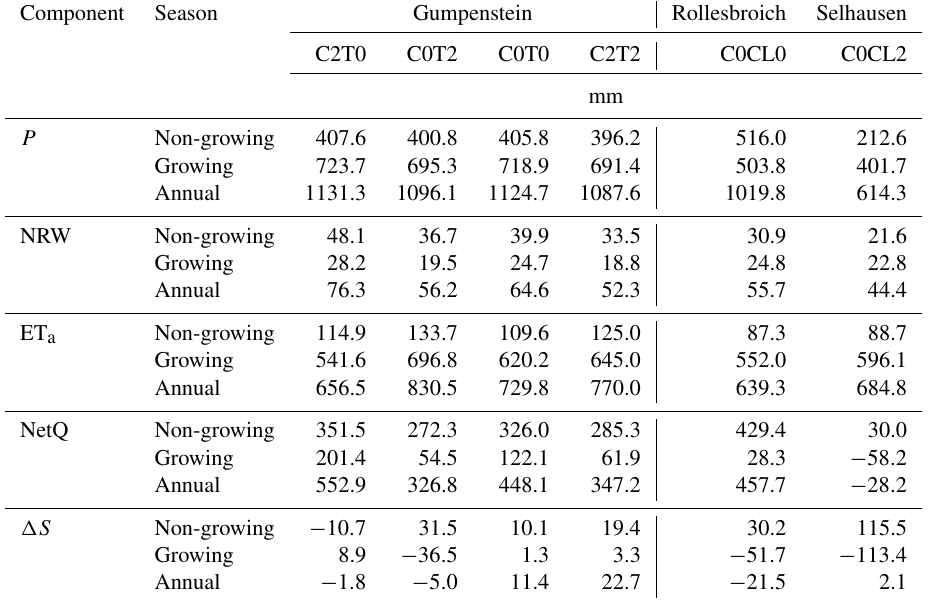
Table 2. Average values of the soil water balance components of precipitation ( P ), non-rainfall water (NRW), actual evapotranspiration (ET a ), net water flux across the lysimeter bottom (NetQ), and change in the soil water storage ( (cid:49)S ). The values were averaged across the non-growing seasons, growing seasons, and annual values for the period 2015–2018 from replicated lysimeter measurements at each test site. This includes Gumpenstein (GS) with C2T0 (CO 2 – + 300ppm; two lysimeters), C0T2 (temperature – + 3 ◦ C; two lysimeters), C0T0 (ambient; one lysimeter), C2T2 (CO 2 – + 300ppm; temperature – + 3 ◦ C; one lysimeter), Rollesbroich (RO) with C0CL0 (original;